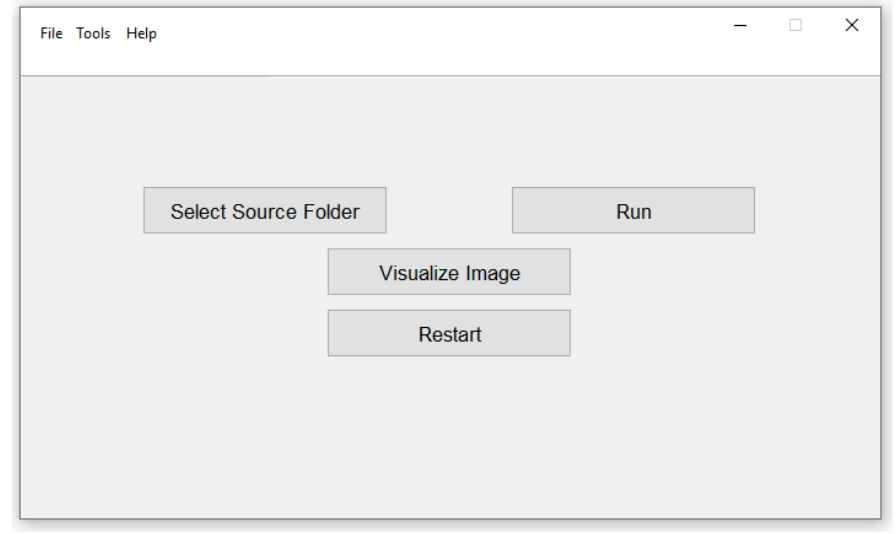
Figure 17. O ffl ine kiwifruit yield estimation Figure 17. Offline kiwifruit yield estimation interface.